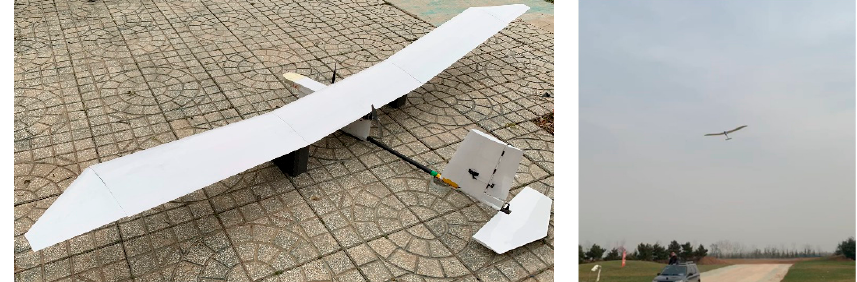
Figure 14. Field flight test of a small hand-launched UAV.